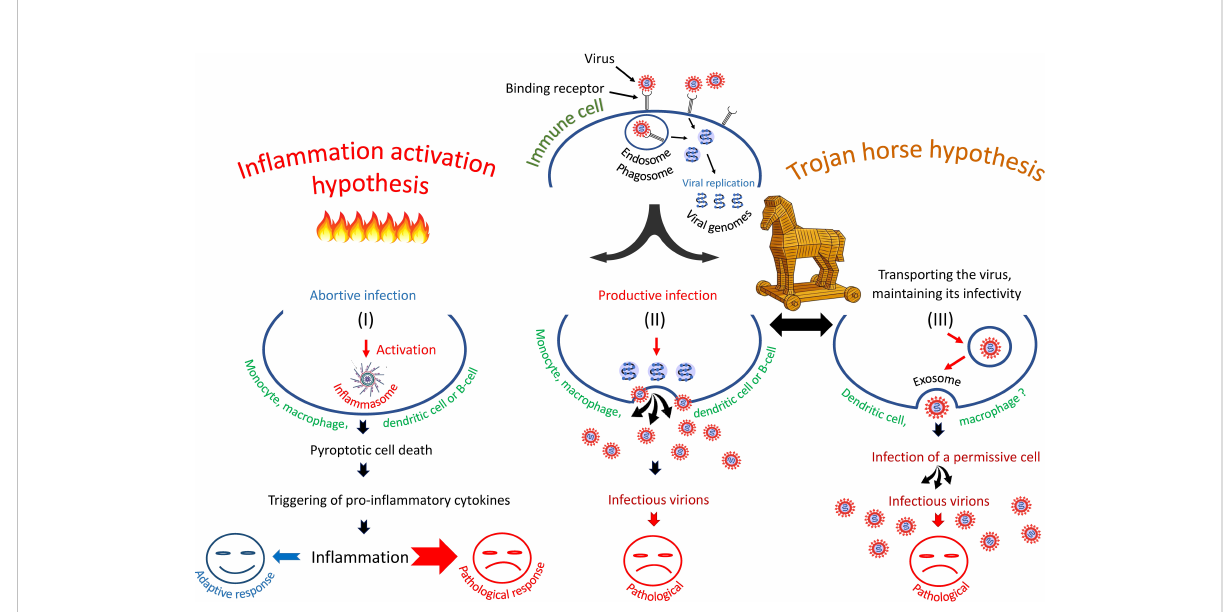
FIGURE 1 Three scenarios of SARS-CoV-2 infection of immune cells: (I) entry of SARS-CoV-2 into immune cells triggers pyroptosis and in fl ammatory cascade, (II) entry of virus into cells leads to productive infection or, (III) entry of virus promotes its transfer to primary permissive target cells, causing their infection. The second and third scenarios are consistent with the "Trojan horse"